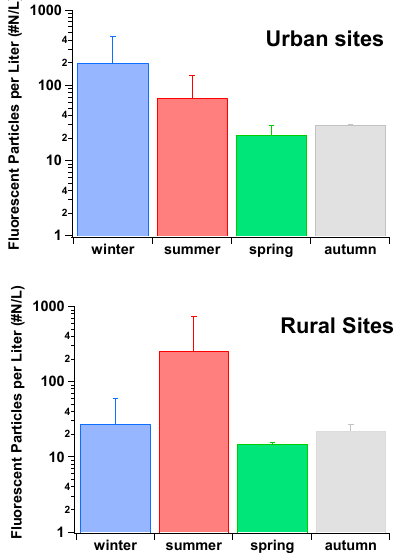
Figure 4. Mean fluorescent particle concentrations measured as a function of site location and temporal period using the UV-APS, WIBS, and BioScout instrumentation.